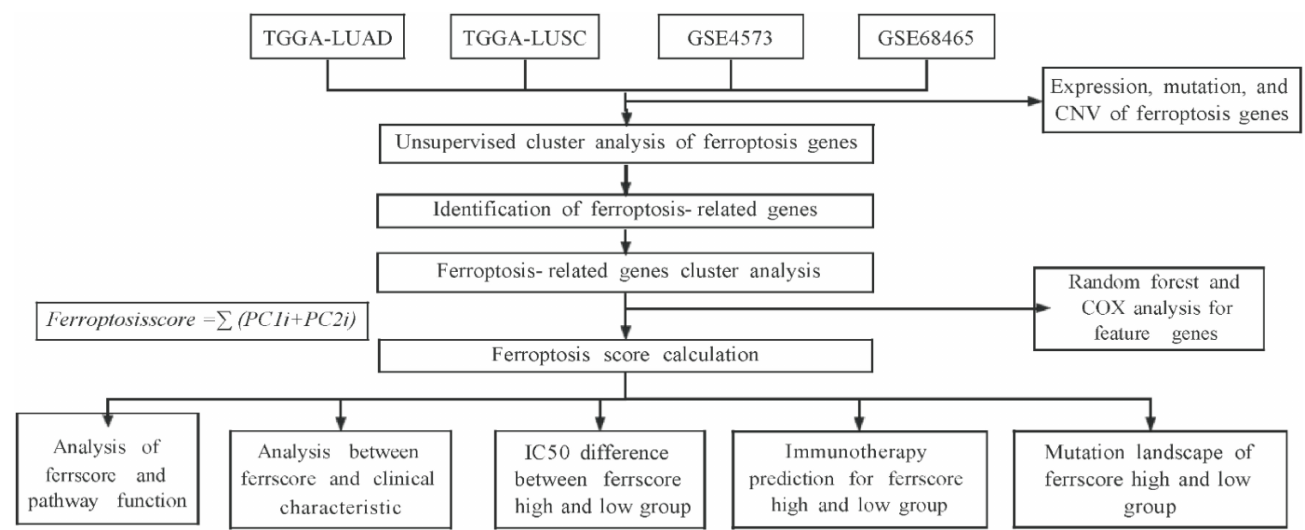
Figure 1. Flow chart of data collection and